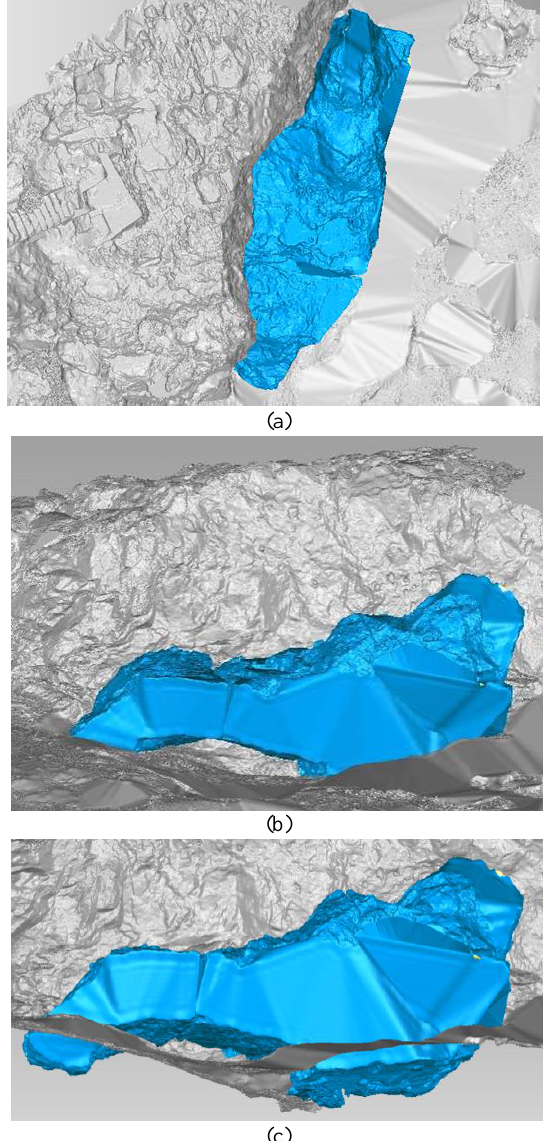
Figure 6: The result of the virtual reconstruction in shaded view; aligned models appear in blue color, (a) ground plan, (b) perspective view, (c) elevation facing